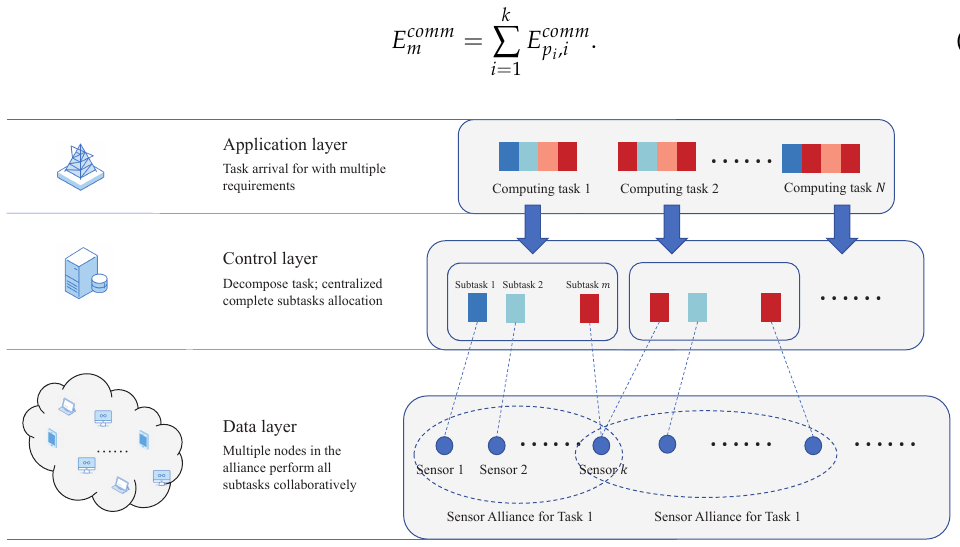
Figure 2. Software-defined heterogeneous edge computing